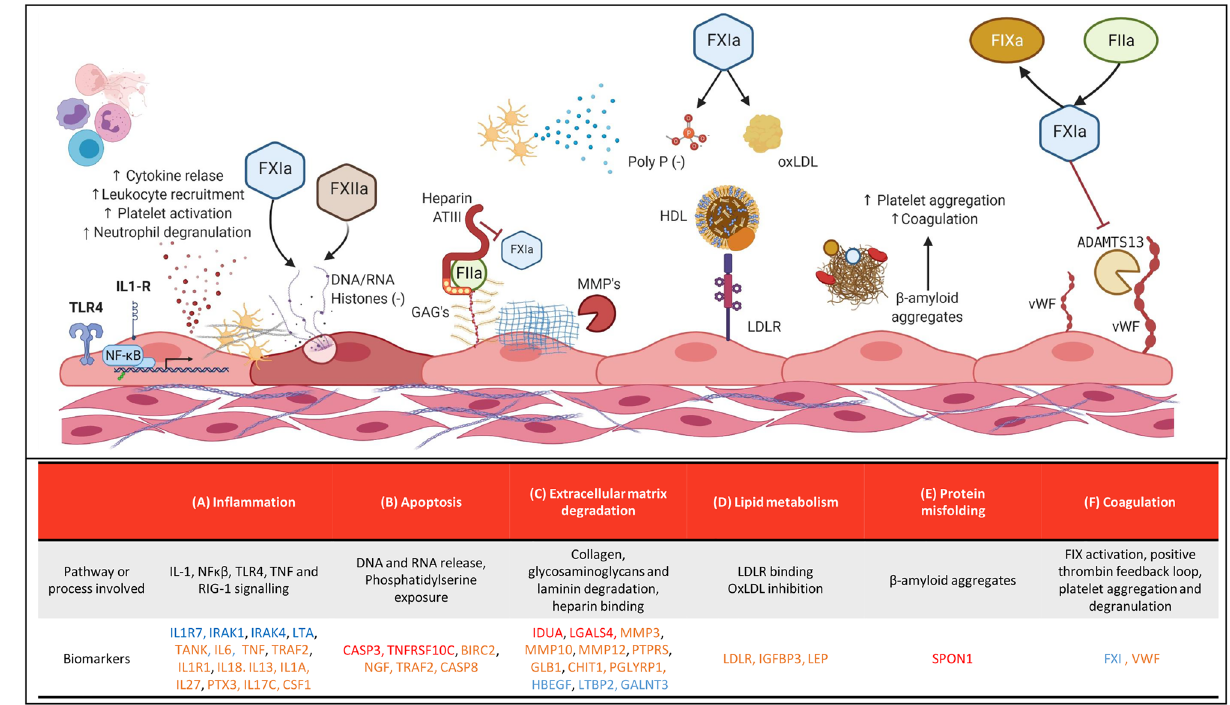
Figure 5. Summary representation of the main pathways and proteins related with FXI:C in the setting of VTE. This summary figure illustrates the main processes and biomarkers related to FXI:C associated proteins. Proteins highlighted in red were associated in the acute VTE event, in orange with the 12-month post-index event and in blue at both time points. ( A ) Cytokine receptors are located on the surface of endothelial cells, enhance the expression of proinflammatory proteins and their release, promote leukocyte recruitment, platelet activation, neutrophil degranulation and netosis (DNA/RNA and histones released), and local inflammation, which could act as a procoagulant environment. ( B ) During apoptosis, apoptotic bodies are released which, together with phosphatidylserine exposure, support a negatively charged surface that can contribute to the activation of FXII and FXI, resulting in increased coagulation activity. ( C ) Extracellular matrix components such as glycosaminoglycans and collagen support a procoagulant surface against different coagulation factors and cell types. Extracellular matrix turnover by proteins involved in degradation of matrix components is a relevant process that prevents the binding and aggregation of platelets and proteins involved in coagulation. ( D ) The products of LDL oxidation (OxLDL) interact with various components of the coagulation system, but are also capable of promoting platelet activation and endothelial dysfunction. ( E ) β-Amyloid protein aggregation may facilitate the aggregation of platelets and coagulation factors, which may lead to thrombus formation in small vessels. ( F ) FXI has the ability to cleave ADAMTS13, which promotes activation of the intrinsic coagulation cascade and platelet aggregation via vWF. Created with